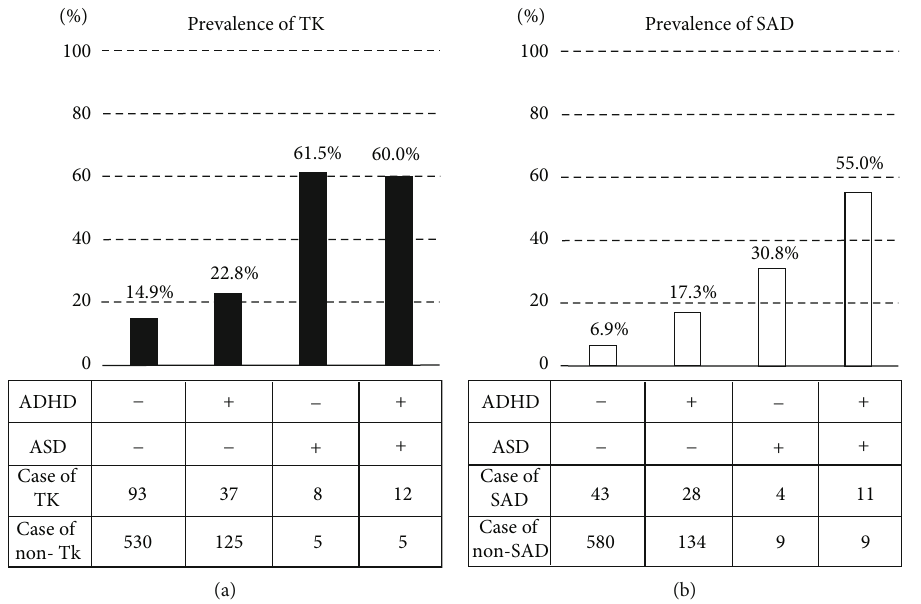
Figure 2: Prevalence of Taijin-Kyofu-sho and social anxiety disorder in participants with neurodevelopmental disorder traits. Participants were divided into four groups (ADHD – ASD – , ADHD + ASD – , ADHD – ASD +, and ADHD + ASD +) to examine the groupwise prevalence of TK and SAD. (a) Black bars indicate the prevalence of TK. (b) White bars indicate the prevalence of SAD. ADHD: attention-de fi cit/hyperactivity disorder; ASD: autism spectrum disorder; TKs: Taijin-Kyofu-sho ; SAD: social anxiety